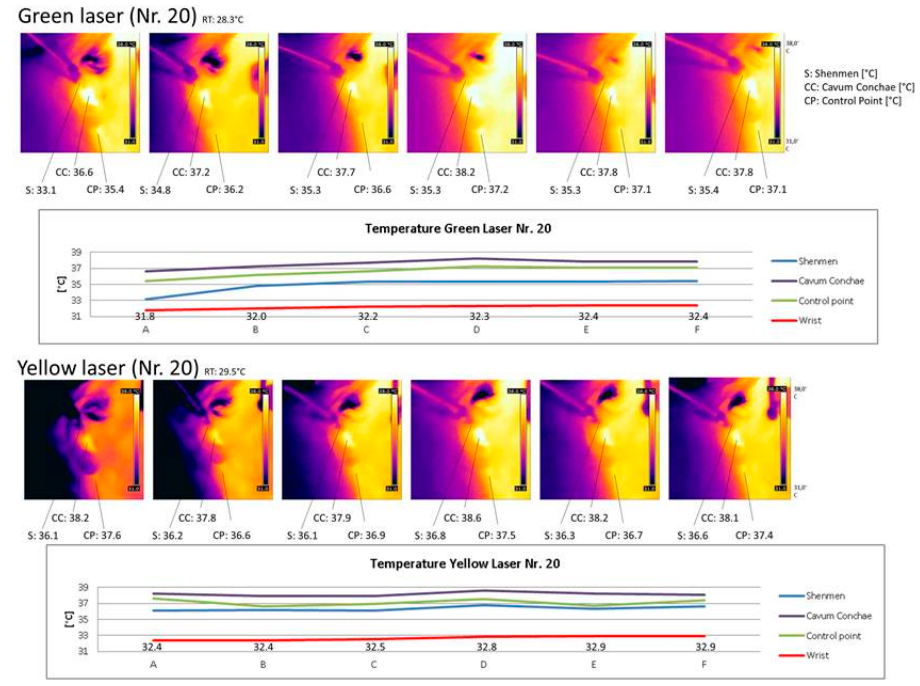
Figure 7. Temperature images and values after green and yellow laser stimulation.